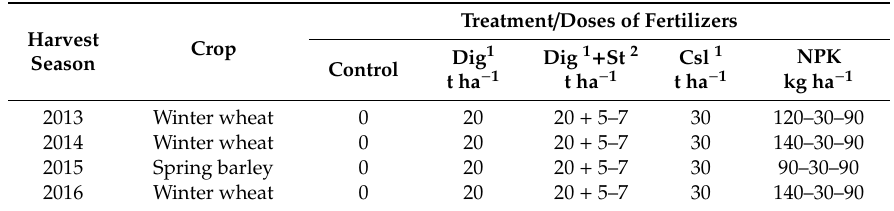
Table 2. Crop rotation and doses of manure, organic, and mineral fertilizers depending on crop and treatment.